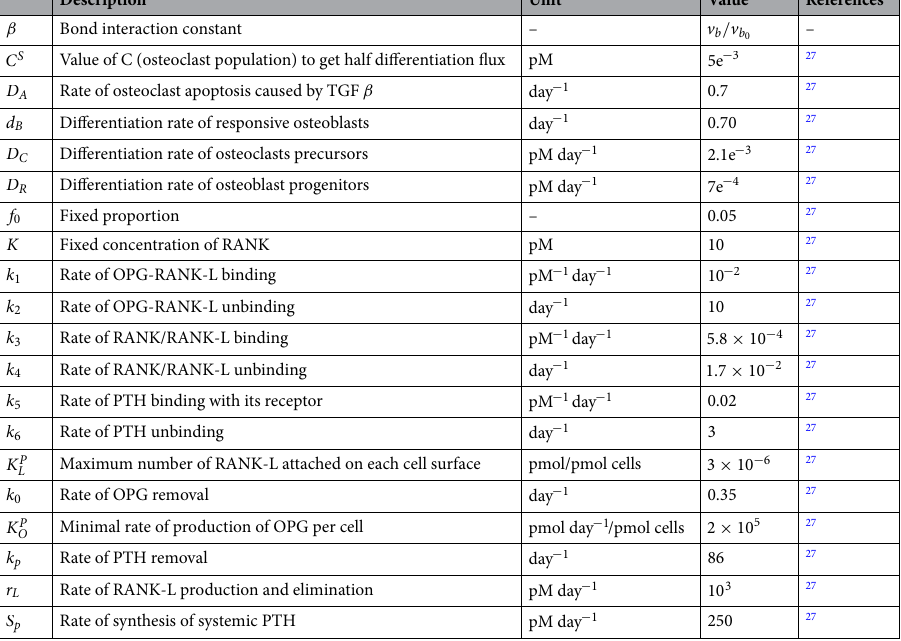
Table 1. Values and description of the chemical